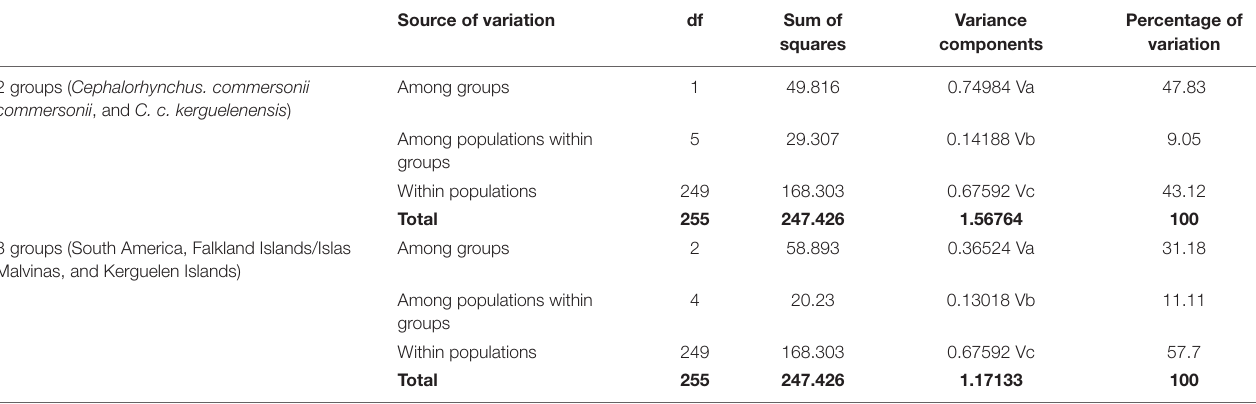
TABLE 3 | Analysis of Molecular Variance performed with Cephalorhynchus commersonii samples grouped according to the subspecies status (two groups) and according to geographic distribution (three groups), after 1,000 permutations.